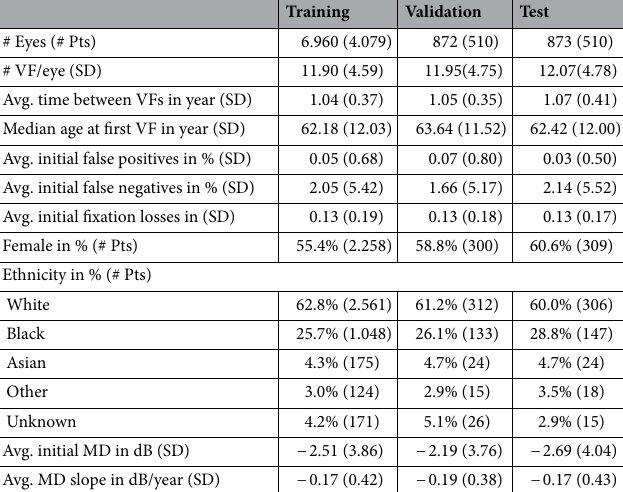
Training Validation